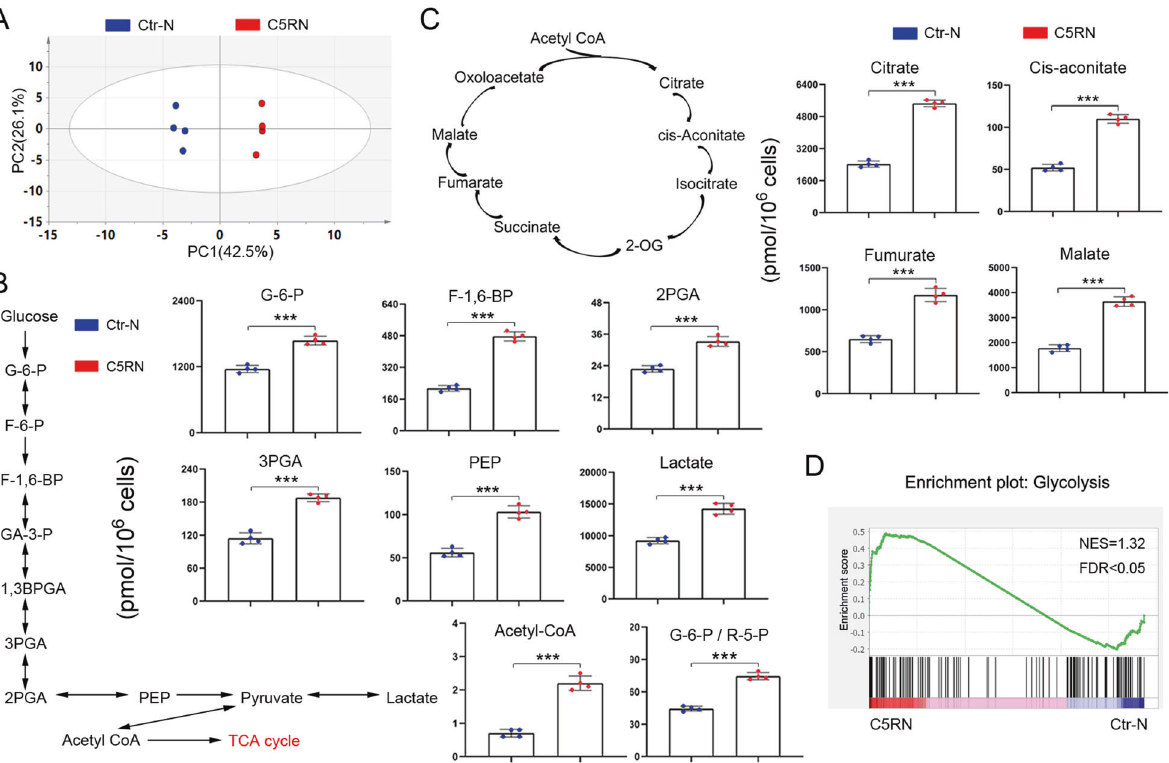
Fig. 2 C5aR1 + neutrophils promote the glycolytic capacities of breast cancer cells. A Principal component analysis of metabolome pro fi le comparing MCF-7 cells cultured with C5aR1 + neutrophils (C5RN) or C5aR1-negative neutrophils (Ctr-N). Data representative of four independent experiments. B Quanti fi cation of metabolic intermediates in glycolysis by metabolic pro fi ling. Absolute values of metabolites are shown. C Quanti fi cation of metabolic intermediates in TCA cycle. Absolute values of metabolites are indicated. D Gene set enrichment analysis shows an enrichment of genes related to glycolysis in MCF-7 C5RN cells. Normalized enrichment score (NES) and false discovery rate (FDR) are indicated. Data represent the mean ± SD of at least three independent experiments. *** P <